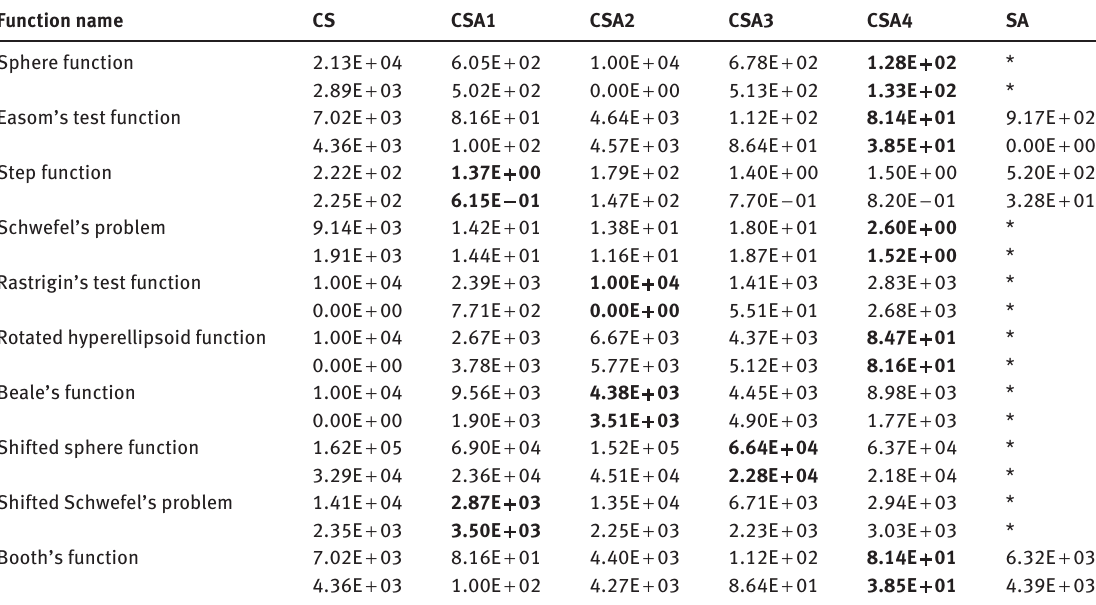
Table 5: Convergence Results of the Algorithms for each of the 10 Benchmark Functions. Function name